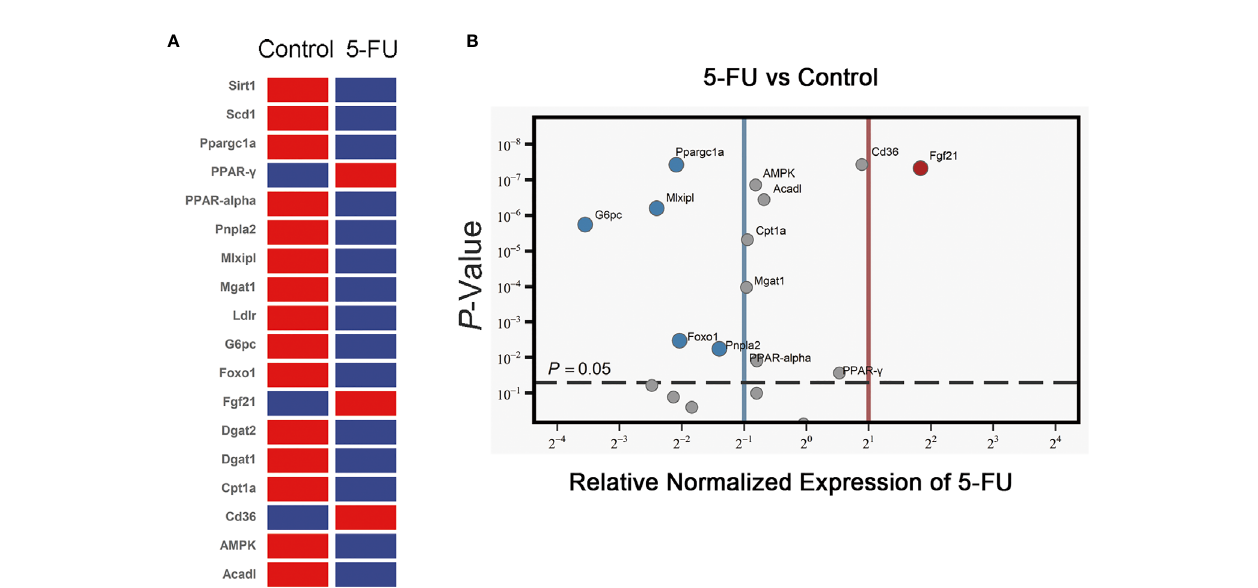
FIGURE 3 | Effects of 5-FU treatment on lipid synthesis, lipid uptake, and lipid metabolism-related gene expression. (A) The expression of genes in the livers of mice was detected by RT-qPCR assay ( n ≧ 6). Clustergram (Red means high mRNA expression level, and blue means low mRNA expression level). (B) Volcano ≧ plot (the left side of the solid blue line represents genes whose mRNA expression level has been reduced by more than two times, the right side of the solid red line represents genes whose mRNA expression level has increased more than twice, and the genes above the gray dotted line indicate that the difference is statistically signi fi cant, p <